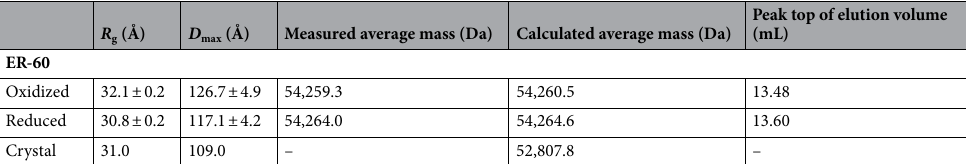
Table 1. The values obtained from the SAXS measurement, SEC, and ESI-TOF MS of